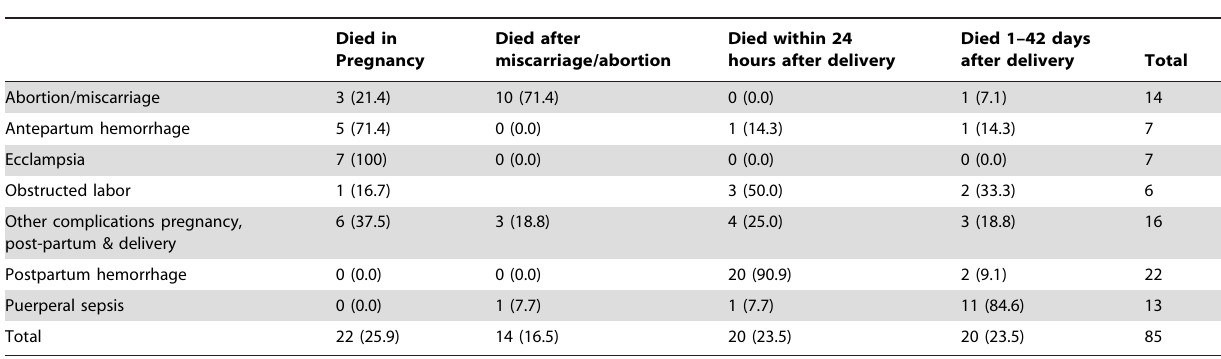
Table 2. Distribution of direct causes of death by phase of